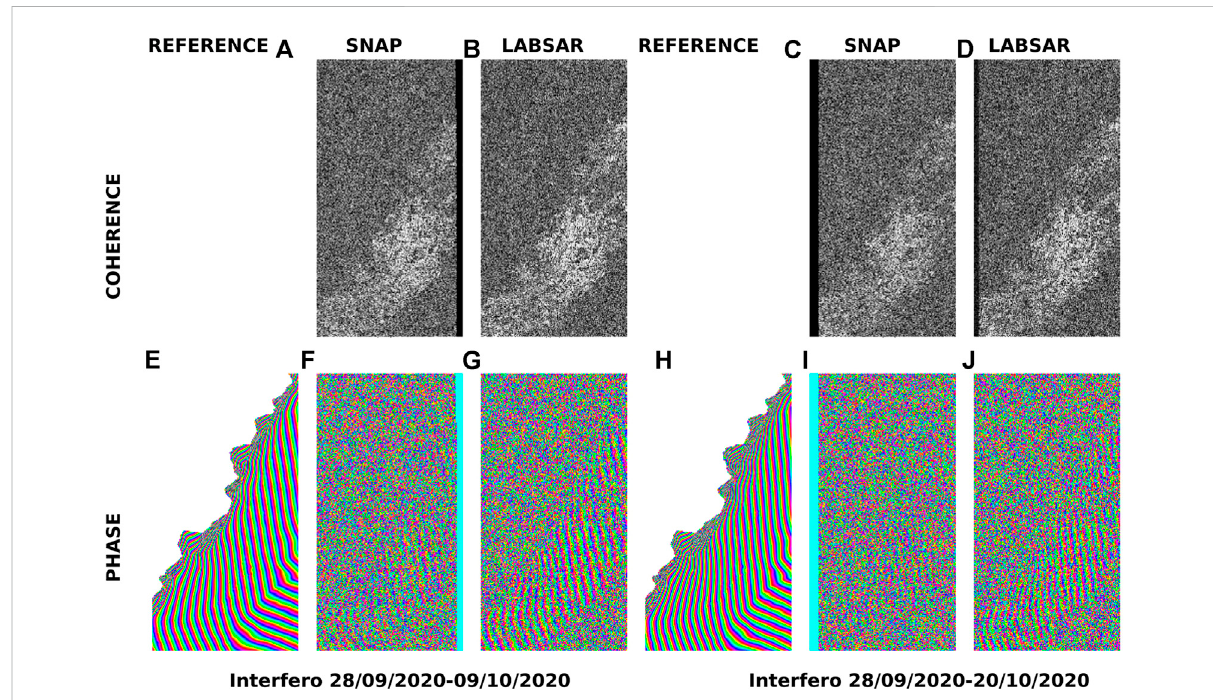
FIGURE 5 Coherence and phase of the interferogram before obrital fringes removal. (A – D) coherence and (E – J) phase of the interferograms (A,B,E,F,G) between the 28/09/2020 and 09/10/2020 images. (C,D,H,I,J) between the 28/09/2020 and 20/10/2020 images. (E,H) simulated phase, (A,C,F,I) SNAP resampling. (B,D,G,J) LabSAR resampling.